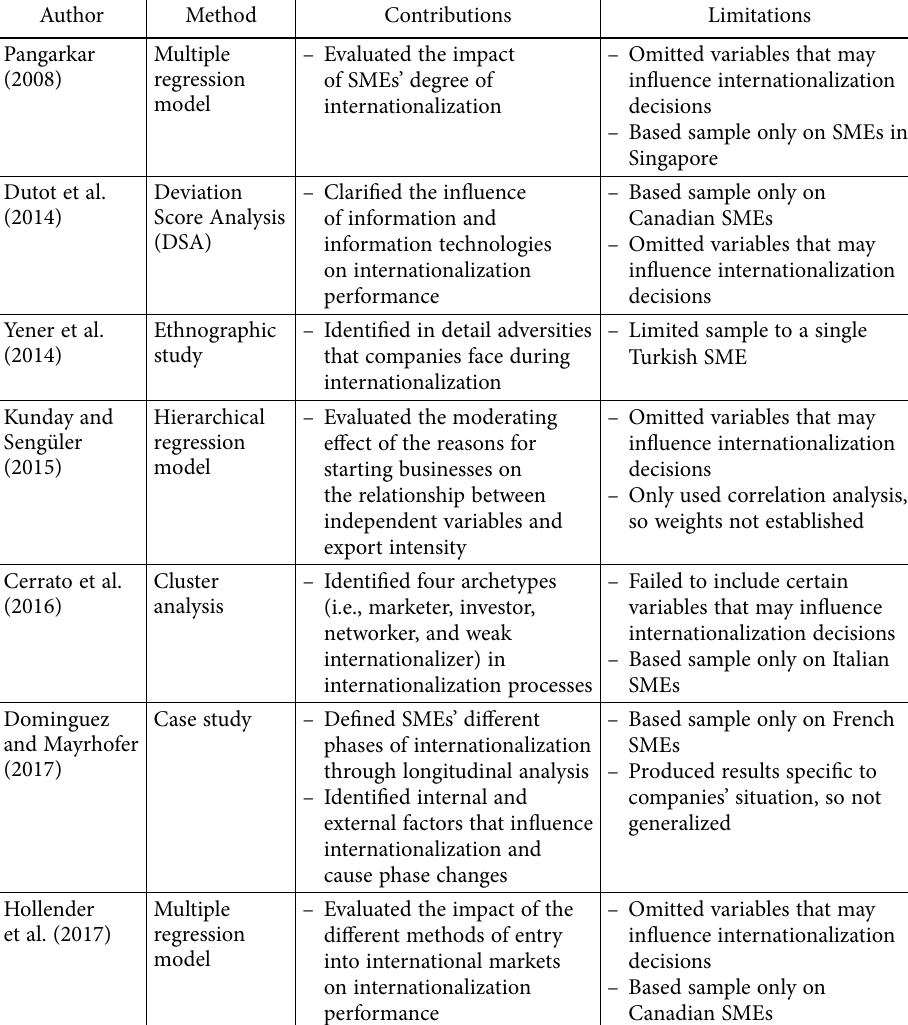
Table 1. Methods for assessing SME internationalization capability: contributions and limitations